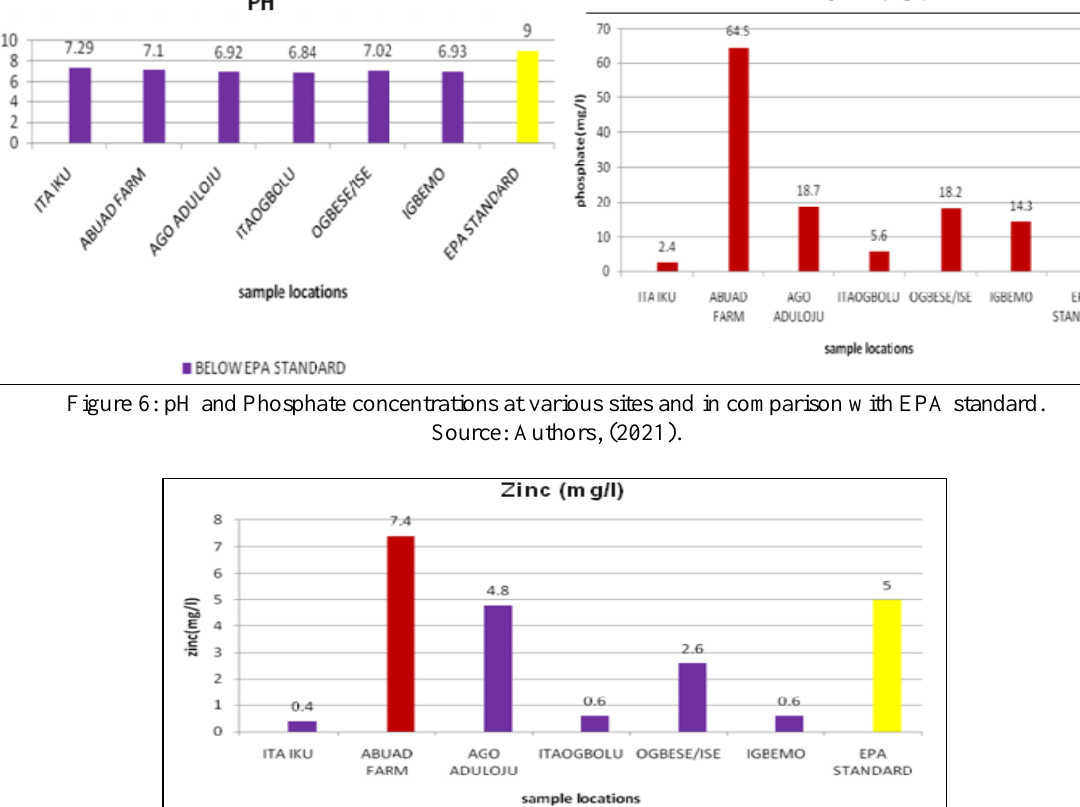
Figure 7: Zinc concentrations at various sites and in comparison with EPA